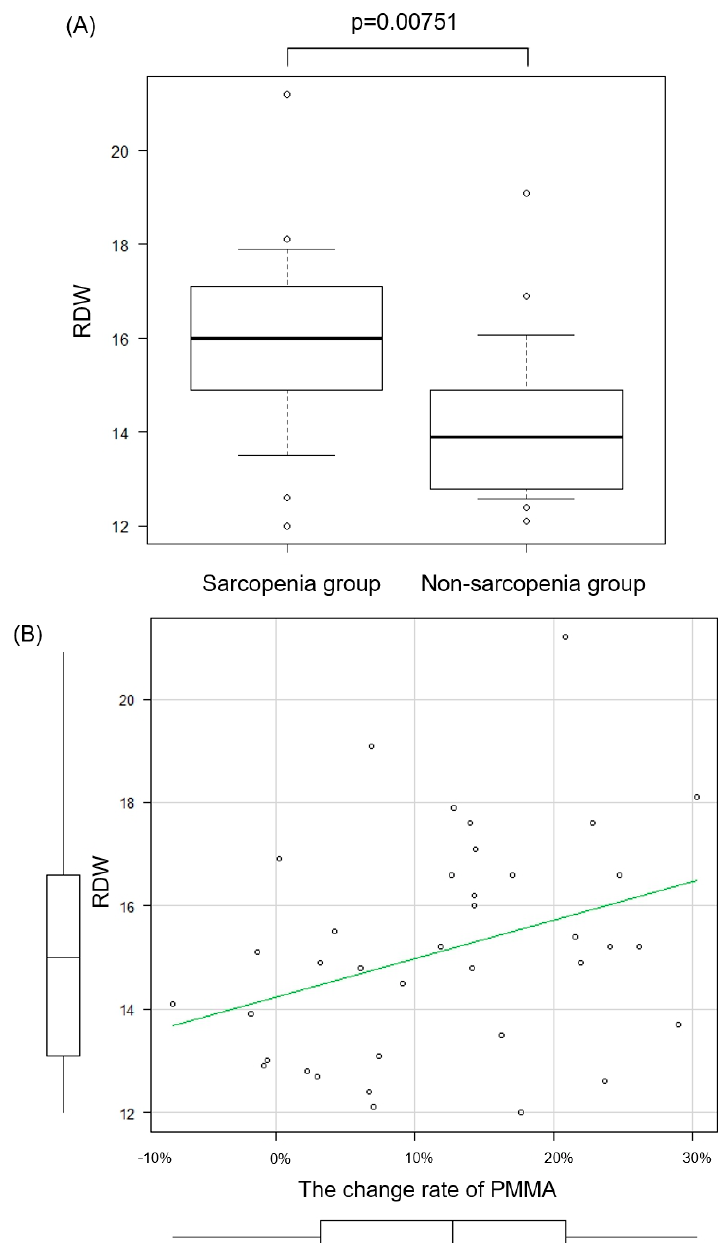
Figure 5. Red cell distribution width (RDW) and sarcopenia. We compared RDW between sarcopenia and non-sarcopenia groups ( A ). Moreover, we evaluated the correlation coefficient by the Spearman’s rank correlation between the change rate of PMMA and RDW ( B